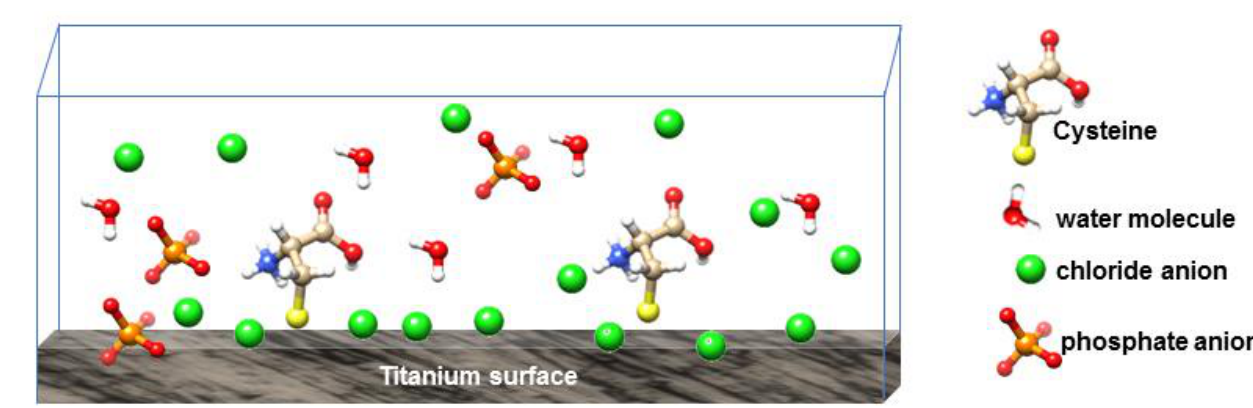
Figure 3. Proposed adsorption behavior of Cys in the solution system on the Ti surface in an acidic environment (pH = 1).